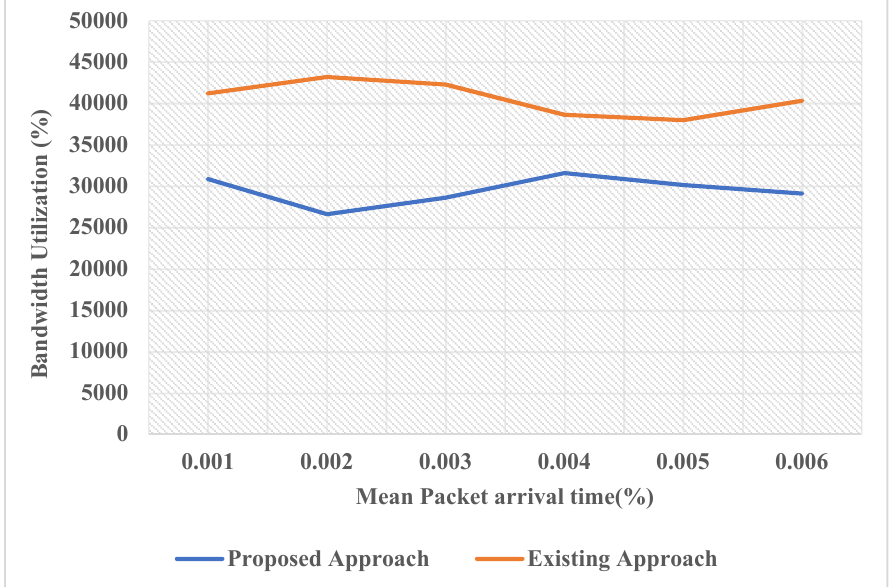
Figure 9. Comparative Analysis between bandwidth utilization and means packet arrival time.